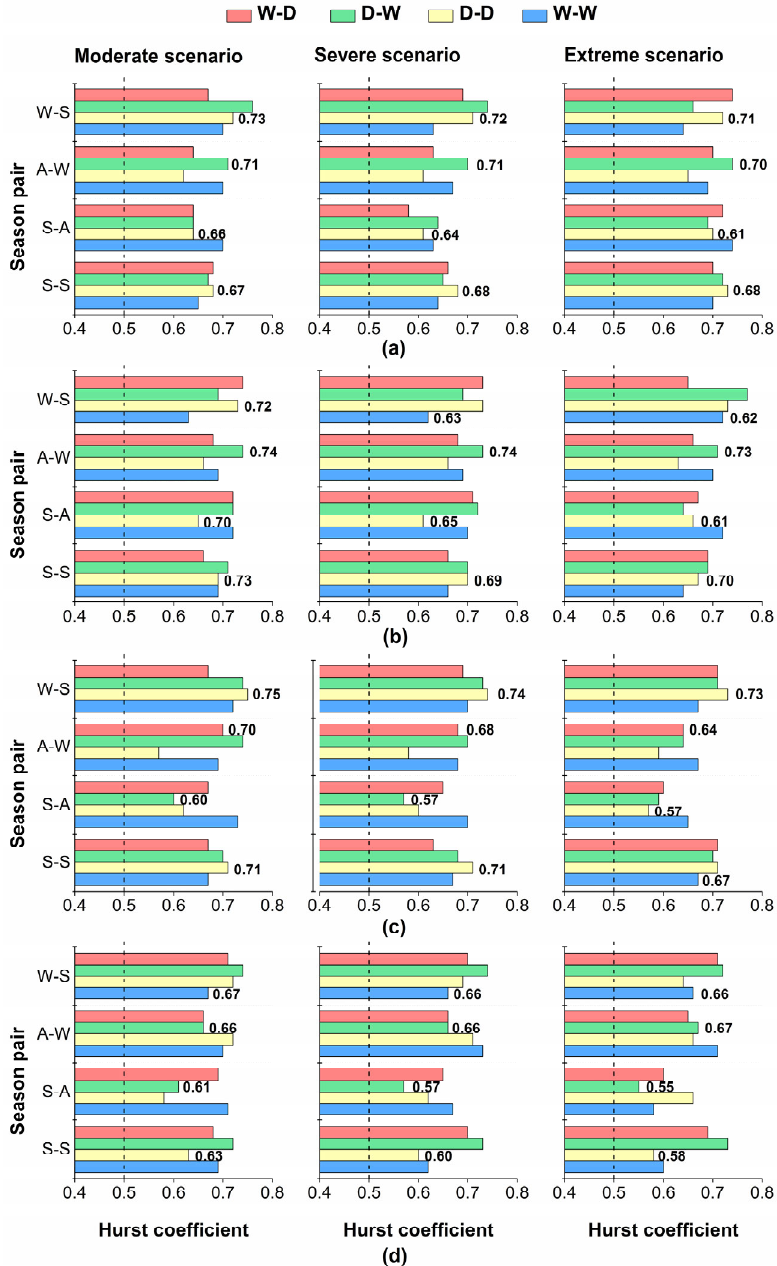
Figure 6. Persistence of trends in return periods of dryness–wetness combinations under three severity level scenarios over the past half-century at ( a ) the upper reach, ( b ) the Yishusi River basin, ( c ) the middle reach and ( d ) the lower reach of the HRB. Results of persistence analysis are presented in the form of the Hurst coefficient. Values in bold correspond to the most frequent combinations identified for each season pair.